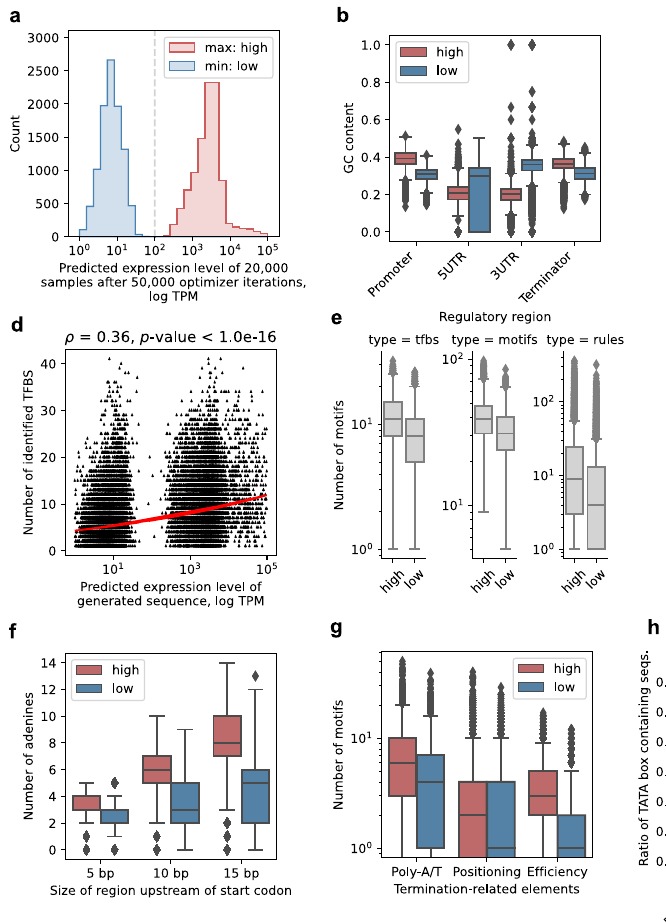
Fig. 5 | ExpressionGAN-generated regulatory DNA carries sequence determi- nantsofgeneexpressioncontrol.a Distributionofpredictedexpressionlevelsof generated sequence samples from low (blue) and high (red) expression bins ( n =10,000 each) after 50,000 iterations of ExpressionGAN optimization (see Fig. 3). TPM denotes transcripts per million. b – k Panels display sequence proper- tiesofthegeneratedsequencesfromthelow(blue)andhigh(red)expressionbins. b GCcontentacrosstheregulatoryregionsofthegeneratedsequences( n =10,000 each). c Overview of fi ndings across the whole generated synthetic regulatory constructs as well as the core promoter regions. Nuc. occ. denotes higher nucleosome occupancy. d Correlation analysis between the amount of identi fi ed TFBS 48 (FIMO 49 q -value<0.05)inpromotersand predicted expression levelsof the generatedsequences( n =20,000).Redlinedenotestheleastsquares fi t.The T -test was used. e Amount of yeast transcription factor binding sites (TFBS) and deep learning-uncovered expression-related motifs and motif association rules 7